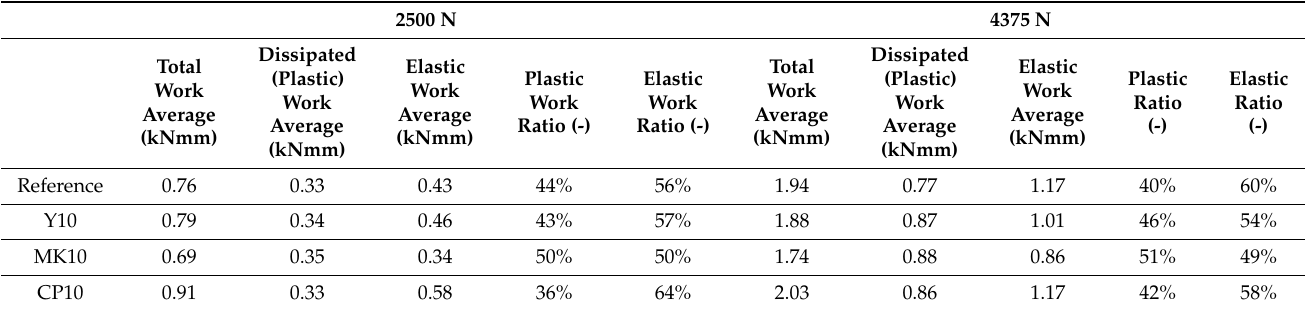
Table 5. Generated indentation energy during the DSI